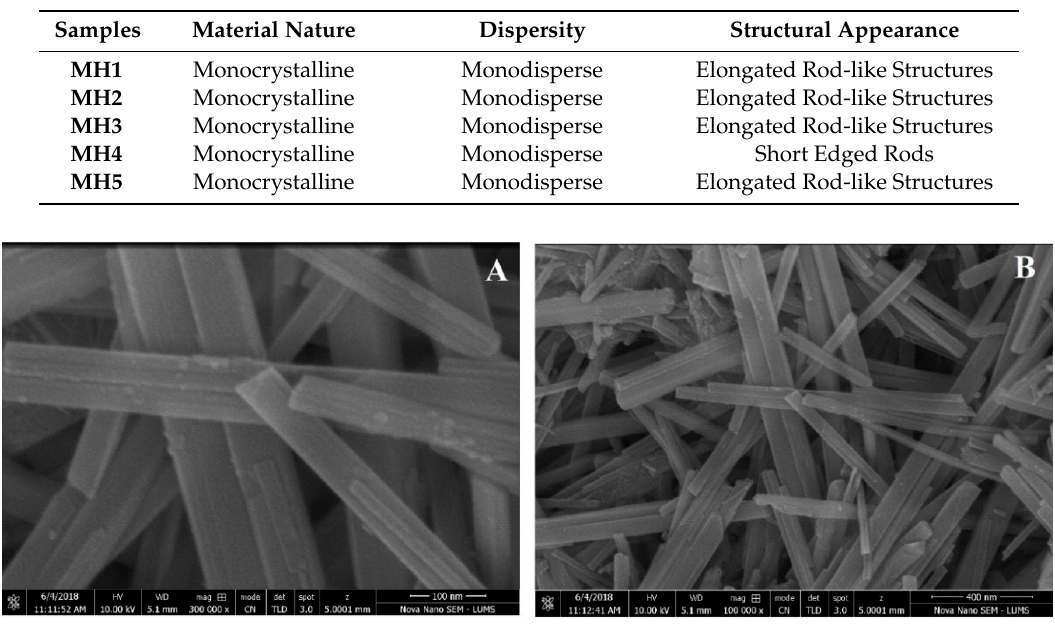
Table 3. Morphological characteristics by SEM analysis of nanomaterials (MH1–MH5).